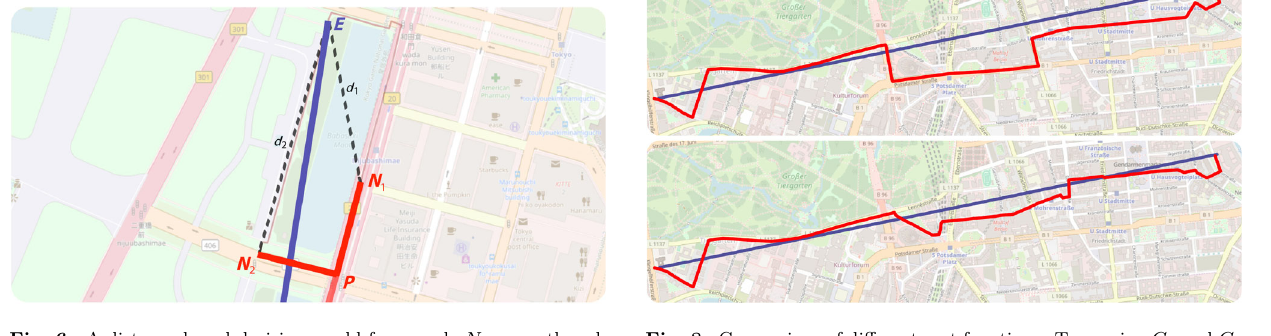
Fig. 8 Comparison of different cost functions. Top: using C 1 and C 2 to approximate the segment. Bottom: adding C 3 to the cost